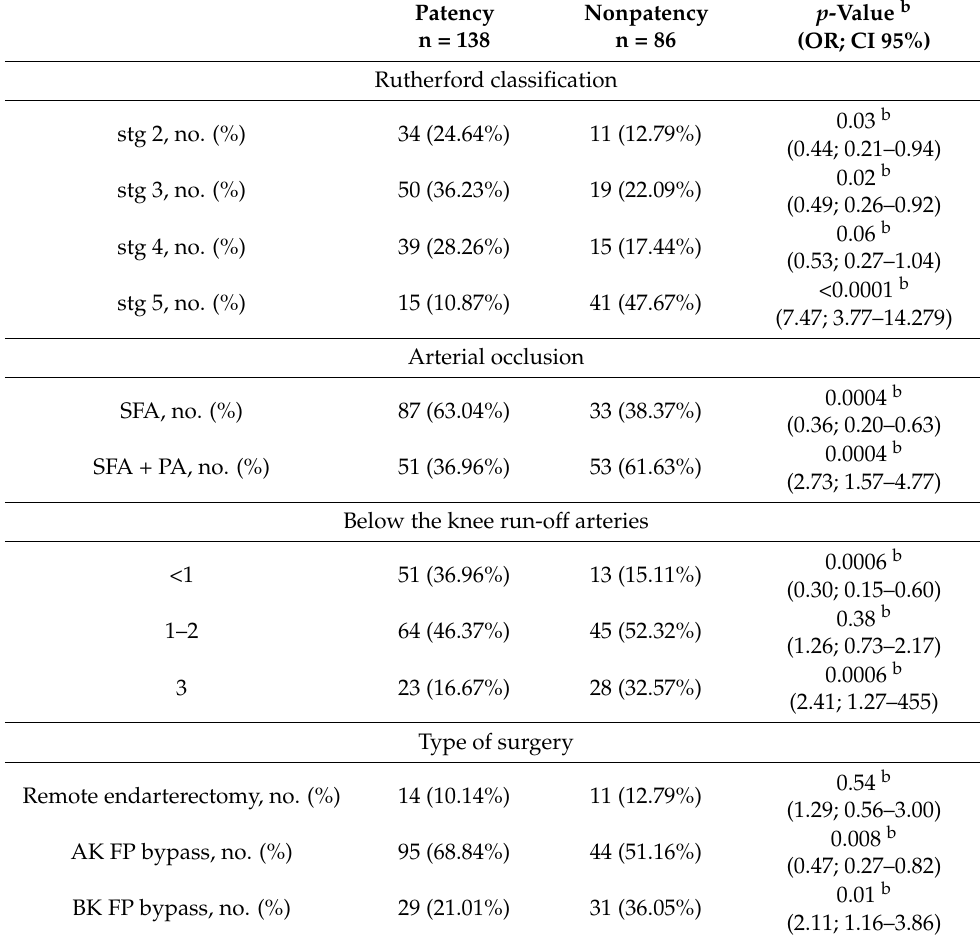
Table 4. Rutherford classification, arterial occlusion, below the knee run-off arteries, and type of surgery of the two subgroups were evaluated according to patency of performed